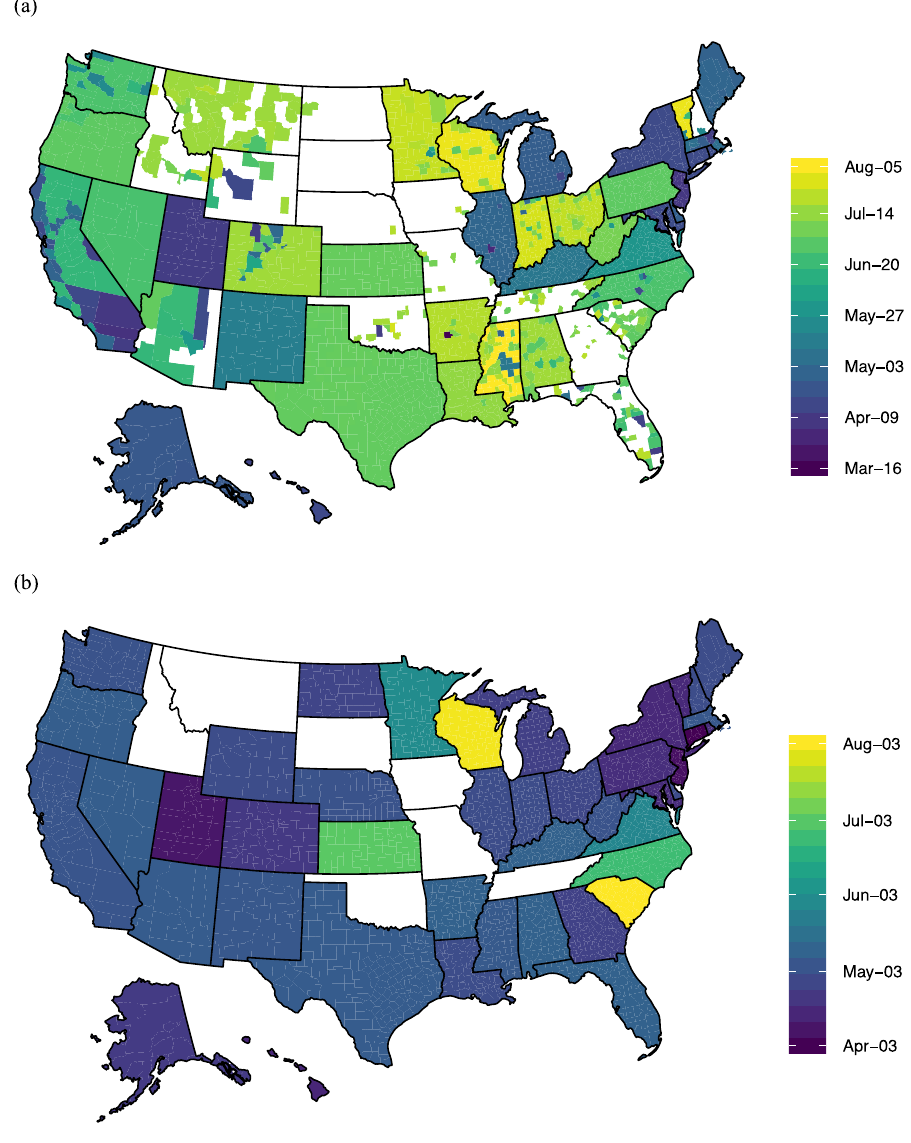
Figure 1. Color scaled dates for face mask mandates ( a ) for public and ( b ) for business. ( Source for ( a ) https ://www.austi nlwri ght.com/covid -resea rch; for ( a ) and ( b ) https ://githu b.com/USCOV IDpol icy/COVID -19-US-State -Polic y-Datab